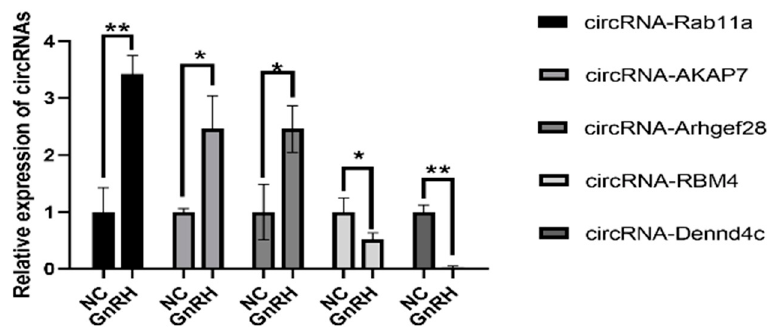
Figure 4. Validation of highly expressed circRNAs. Highly expressed circRNAs were detected by RT-qPCR. The data are shown as the mean ± SD of at least three independent experiments. The data are shown as the mean ± SD of at least three independent experiments. Statistical significance was analyzed by one-way ANOVA (* p < 0.05; ** p < 0.01).